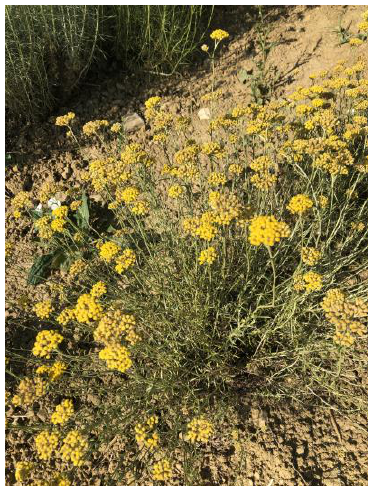
Figure 1. Cultivated Helichrysum italicum plant in flowering stage (Photo: Katja Kramberger). Characteristic yellow fade-resistant inflorescences (seen in Figure 1) as well as vege- tative aerial organs of H. italicum are a treasury of bioactive secondary metabolites that